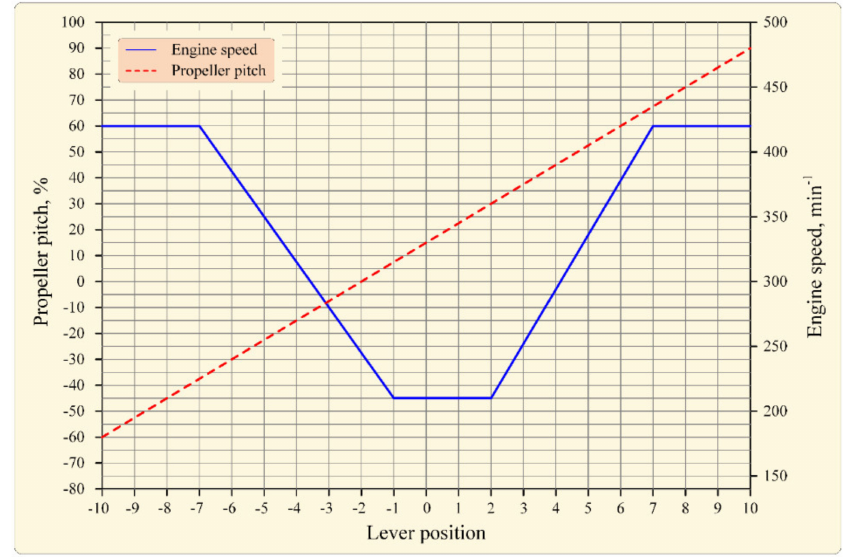
Figure 5. Example of CPP propeller combinator working